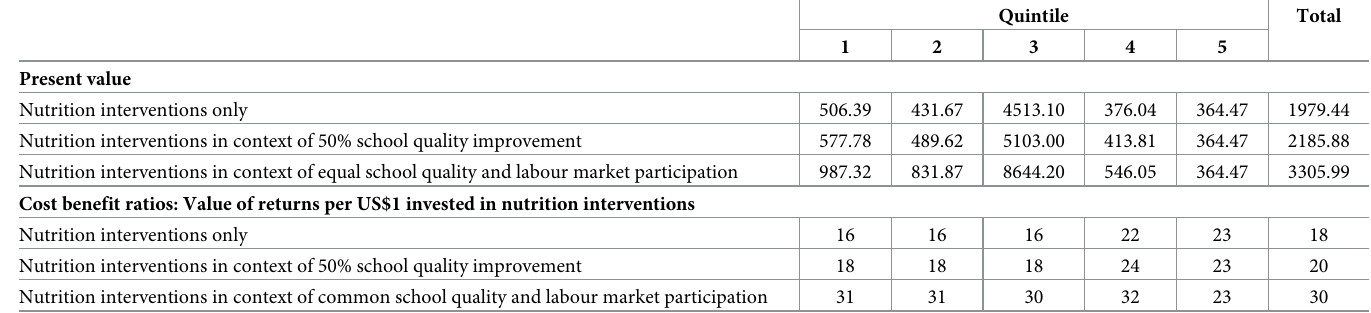
Table 4. Productivity returns (Millions 2020 US$) and benefit cost ratios of scaling 10 early nutrition interventions, with and without changes to